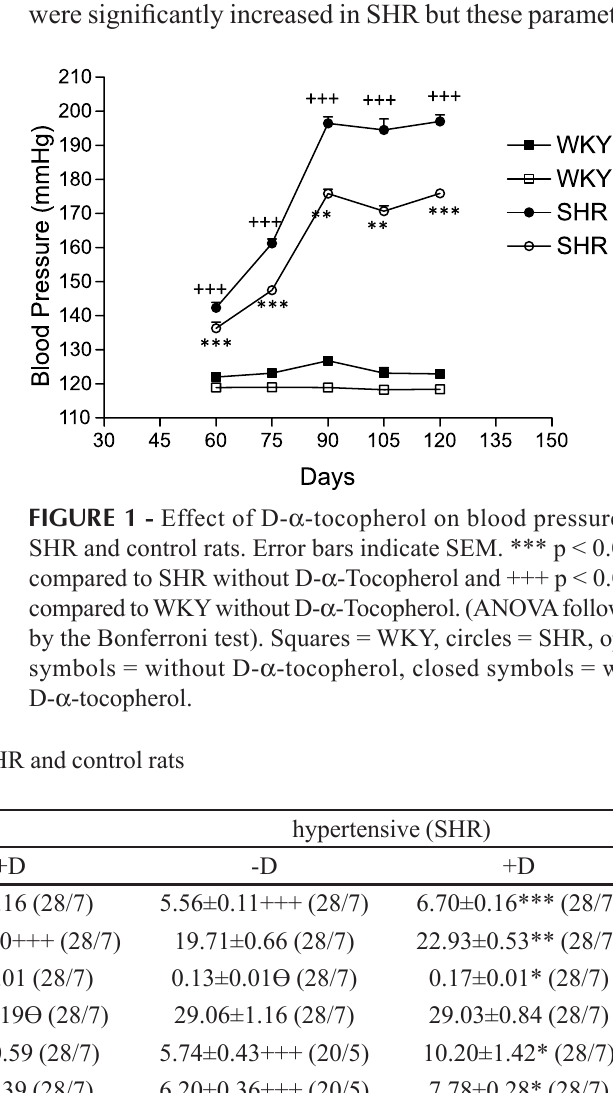
+ = excreted amount of N A